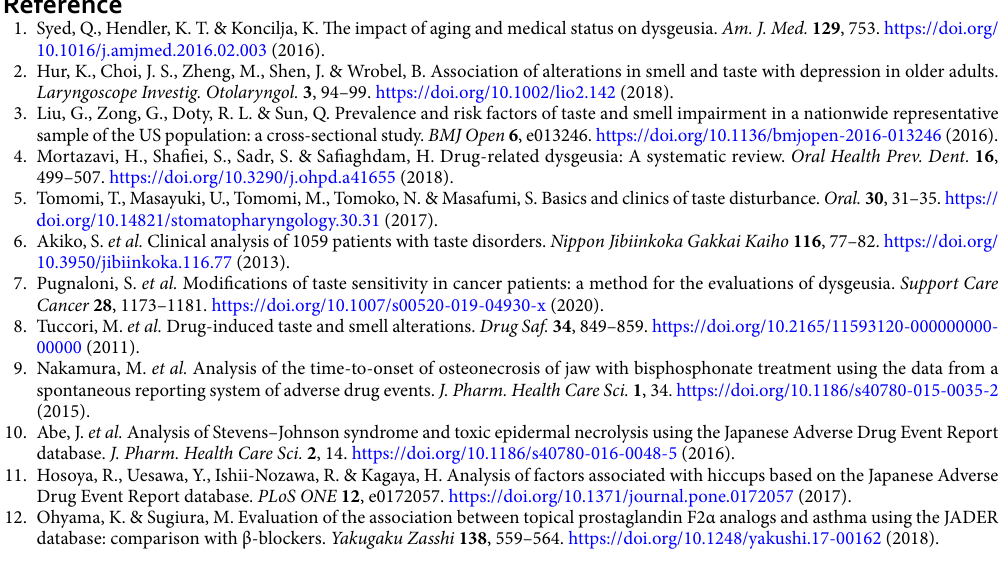
Figure 6. Multiple logistic regression equation for calculating the adjusted odds